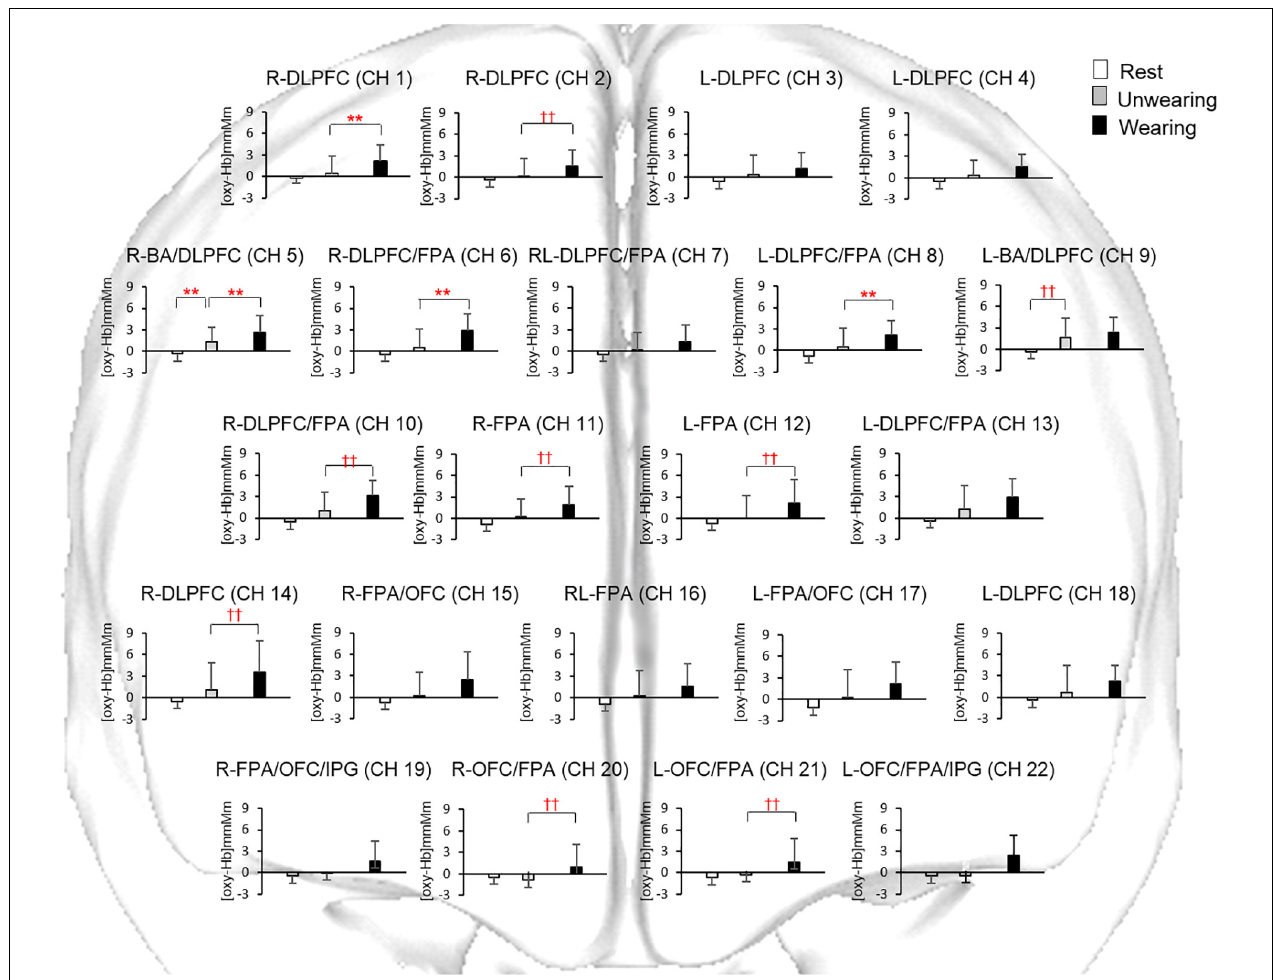
FIGURE 4 | Accumulated oxygenated hemoglobin concentration [(oxy-Hb)] under the Rest condition and during chewing under the Unwearing and Wearing conditions. Statistical analyses were performed using one-way repeated measures ANOVA and pairwise multiple comparison procedures of Tukey’s test, as well as Dunn’s test. **Significant difference between Rest and Unwearing, and between Unwearing and Wearing conditions (one-way repeated-measures ANOVA and Tukey’s test, p < 0.01). †† Significant difference between Rest and Unwearing, and between Unwearing and Wearing conditions (Friedman’s repeated-measures ANOVA on ranks and Dunn’s test, p < 0.01). Accumulated [oxy-Hb] under Unwearing significantly increased for BA/DLPFC (CH 5, 9) as compared to Rest condition. Accumulated [oxy-Hb] under Wearing also significantly increased for DLPFC (CH 1, 2, 14), BA/DLPFC (CH 5), DLPFC/FPA (CH 6, 8, 10), FPA (CH11, 12), and FPA/OFC (CH 20, 21) as compared to Unwearing